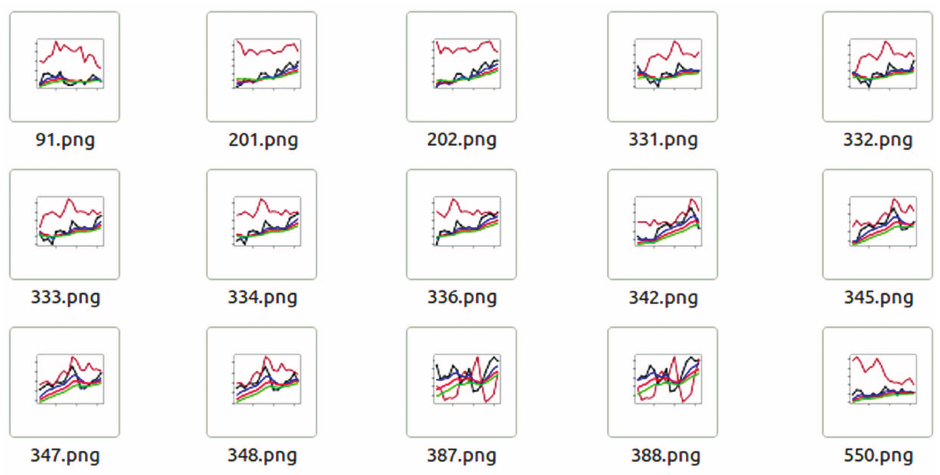
Figure 35: Experiment 3 using Open, Close, MA5, MA10, and MA20 with Label